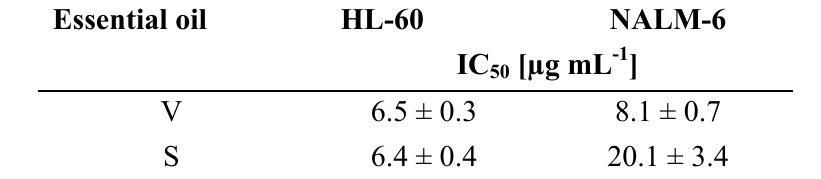
values were determined by the 50